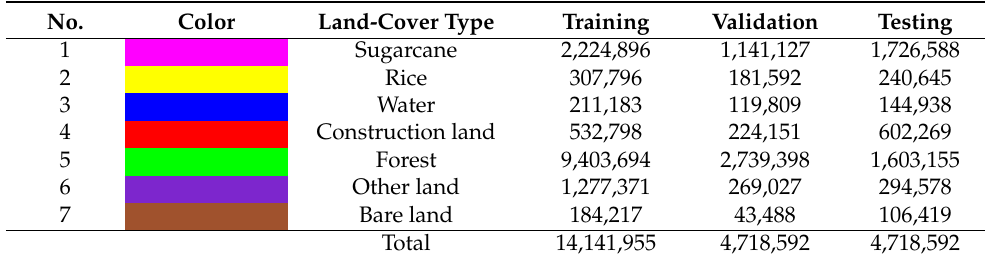
Figure 8. Test set images: ( a ) dataset I true-color, ( b ) dataset I ground-truth maps, ( c ) dataset II true-color and ( d ) dataset II ground-truth maps. Table 1. Numbers of samples in the dataset